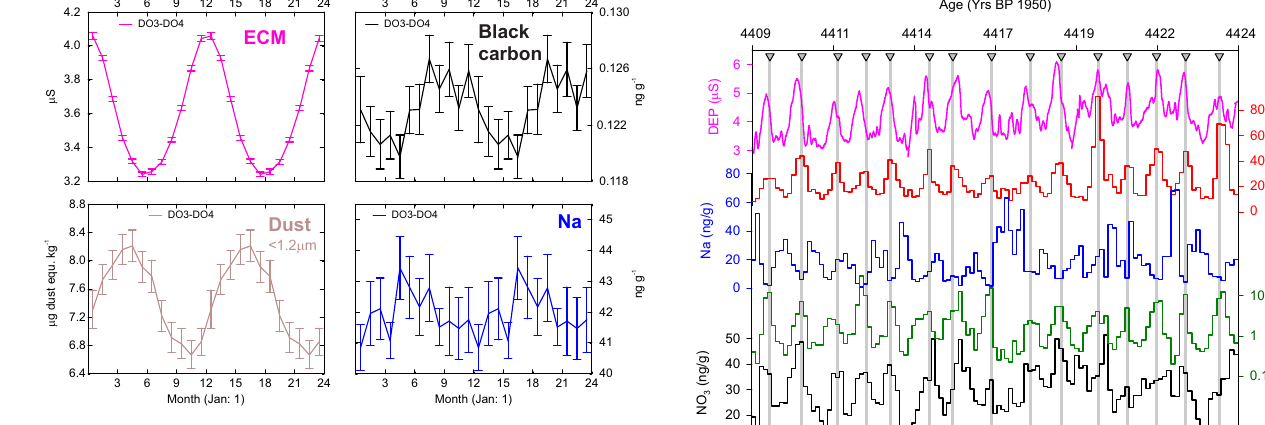
Figure 3. Average annual cycles for WAIS Divide aerosol records similar to Fig. 2, but for a 1250-year period between the onset of Dansgaard–Oeschger (DO) events 3 and 4 (i.e. 28.1–29.4ka), as determined from the WAIS Divide CH 4 record (Buizert et al., 2015). Shown are average monthly values for two complete annual cycles (January: month 1) assuming constant snowfall distribution throughout the year. Uncertainty bars are 1 σ standard error of the mean. Average WAIS Divide annual-layer thickness for this interval is 3.4 ± 0.7cma − 1 .